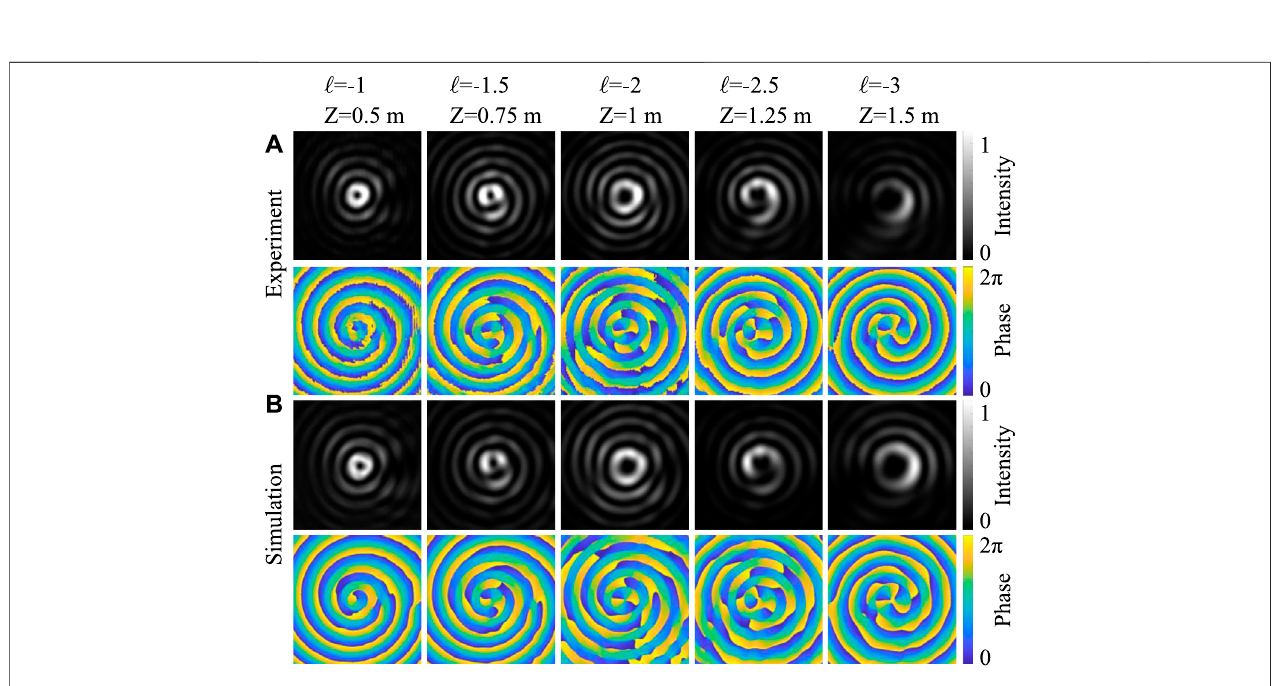
FIGURE 3 | Intensity and phase patterns of anomalous vortices generated by a beam of 632.8 nm through a clockwise spiral axicon at different distances z . (A) Experimental results; (B) simulation results. The top of the fi gure is marked with the PLTC l of the corresponding propagation distance z calculated by Eq. 2 .